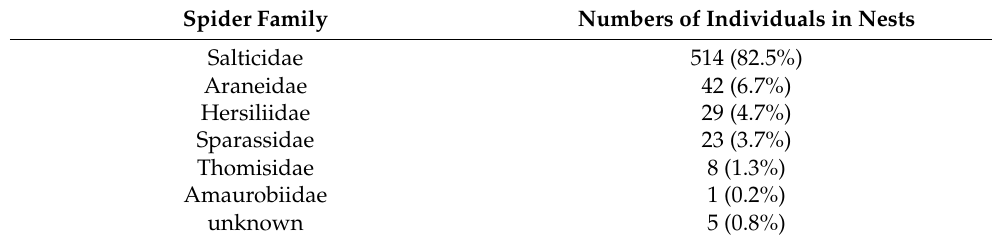
Table 1. Spider composition of 43 nests, including at least seven spider families.